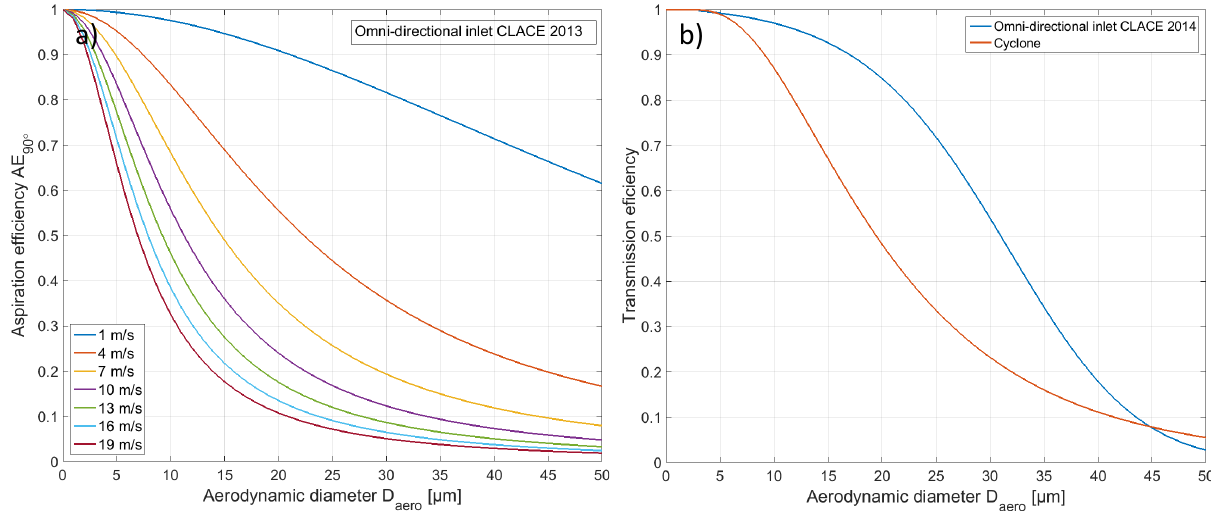
Figure 2. CLACE 2013 omnidirectional inlet (used during CLACE 2013) aspiration efficiency for 90 ◦ sampling (a) , CLACE 2014 omnidi- rectional inlet transmission efficiency (blue curve in panel b ) and cyclone (orange curve in panel b ) transmission efficiency as a function of aerodynamic diameter D aero for standard temperature and